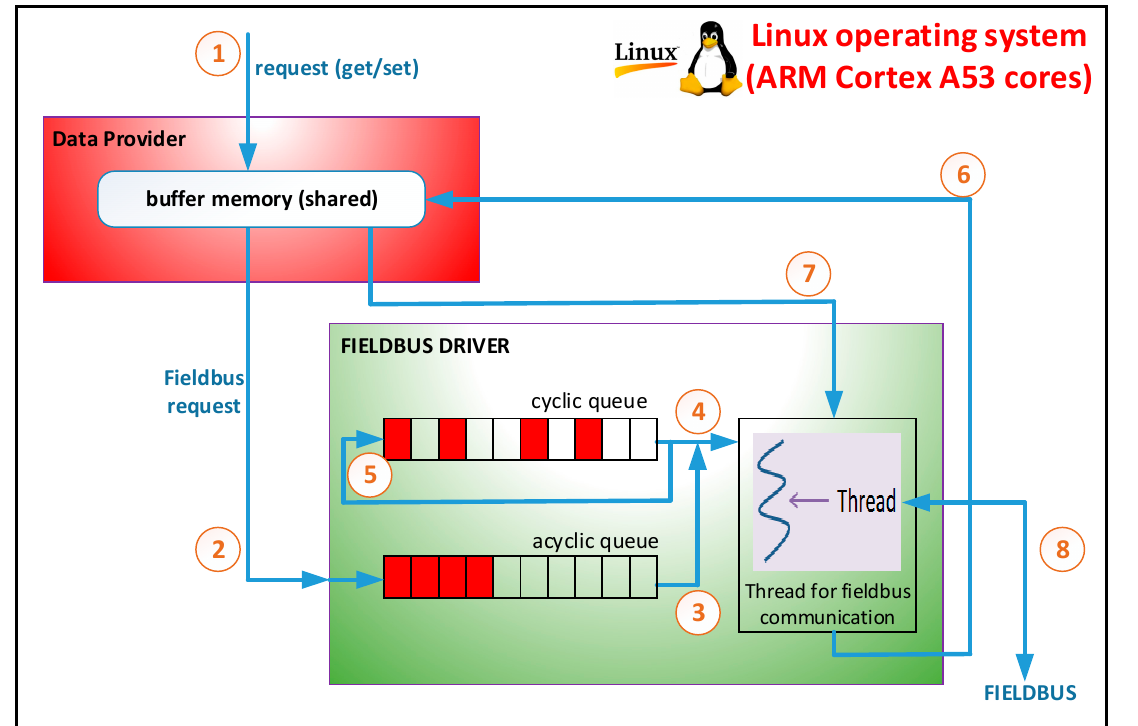
Figure 3. The operation diagram for a CANOpen fieldbus driver.